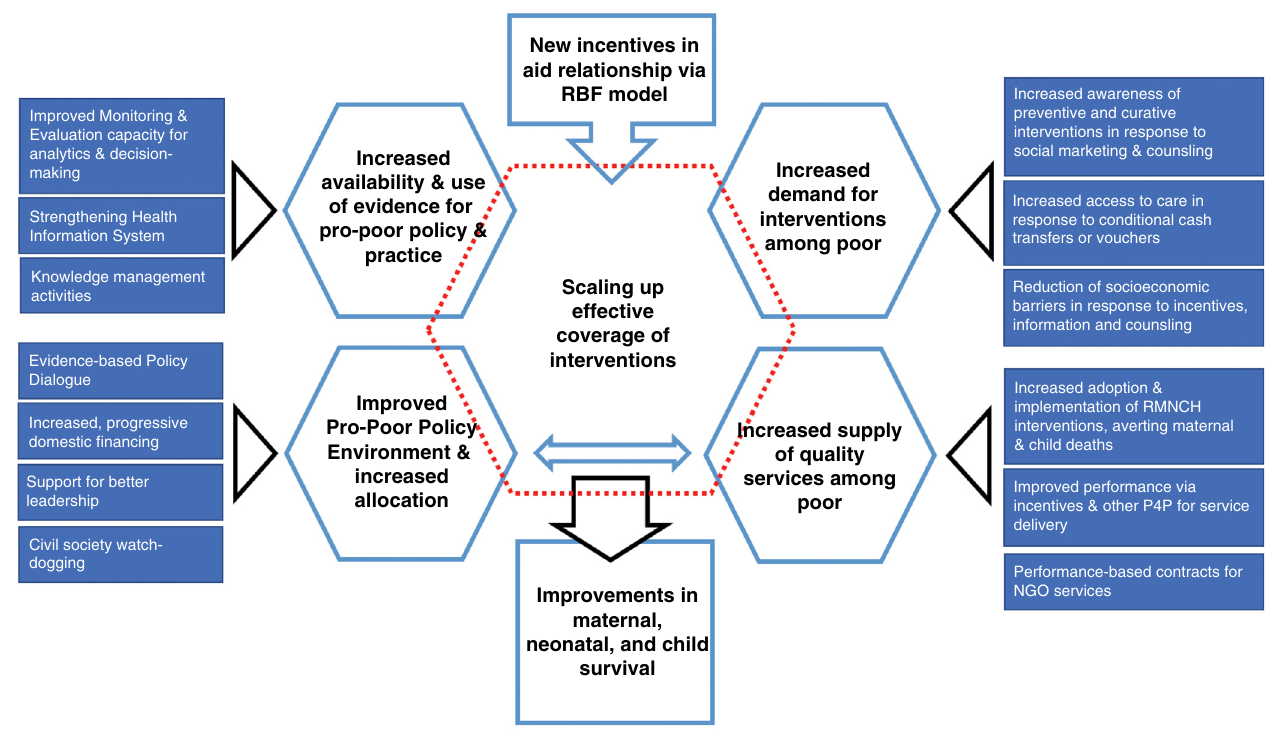
Figure 1. SMI initial theory of